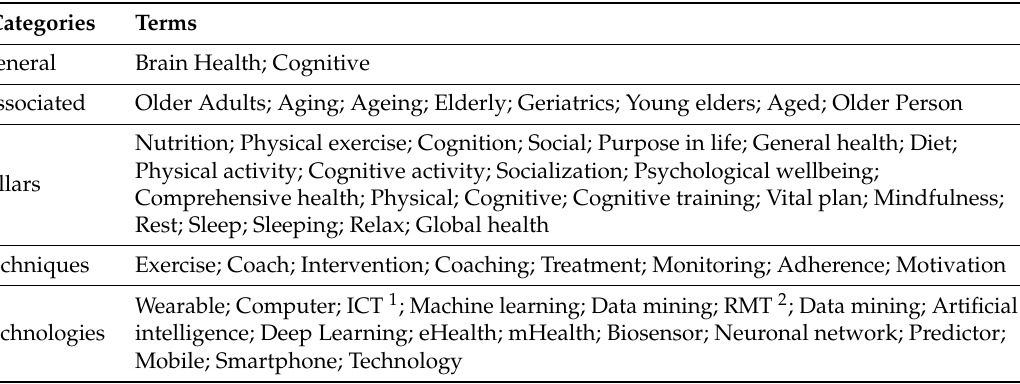
Table 1. Search terms and categories. Terms appear separated by